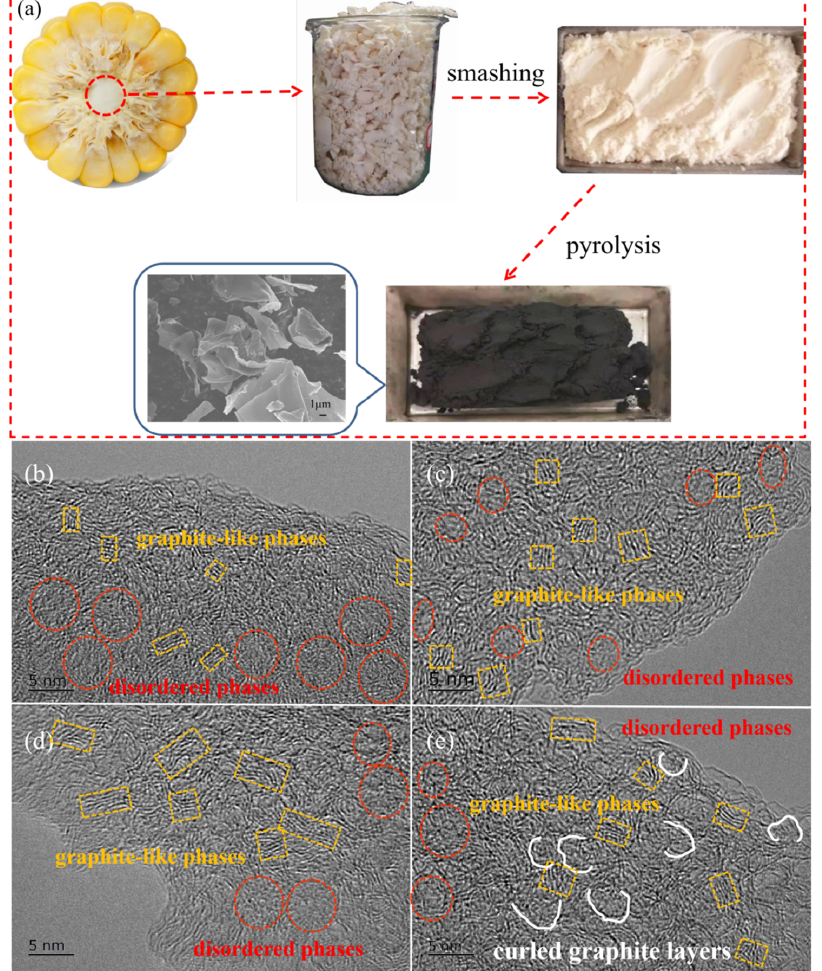
Figure 1. ( a ) Preparation process of corncob-derived hard carbon materials. High-resolution TEM images of CC-1000 ( b ), CC-1200 ( c ), CC-1400 ( d ), and CC-1600 ( e ).